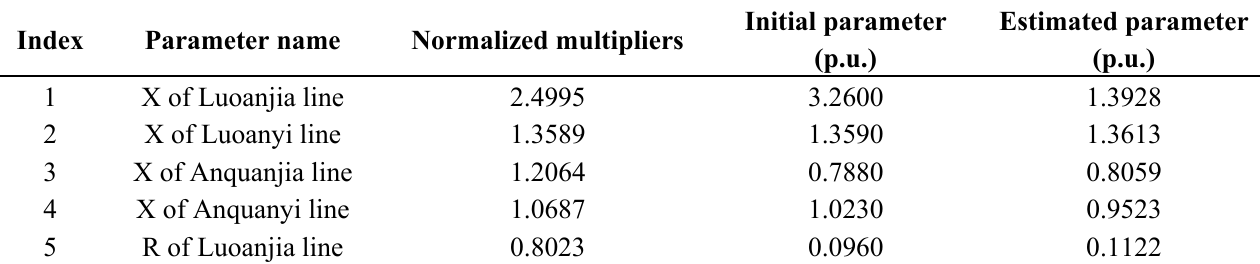
Table 3. PEI and PE results for a provincial system.